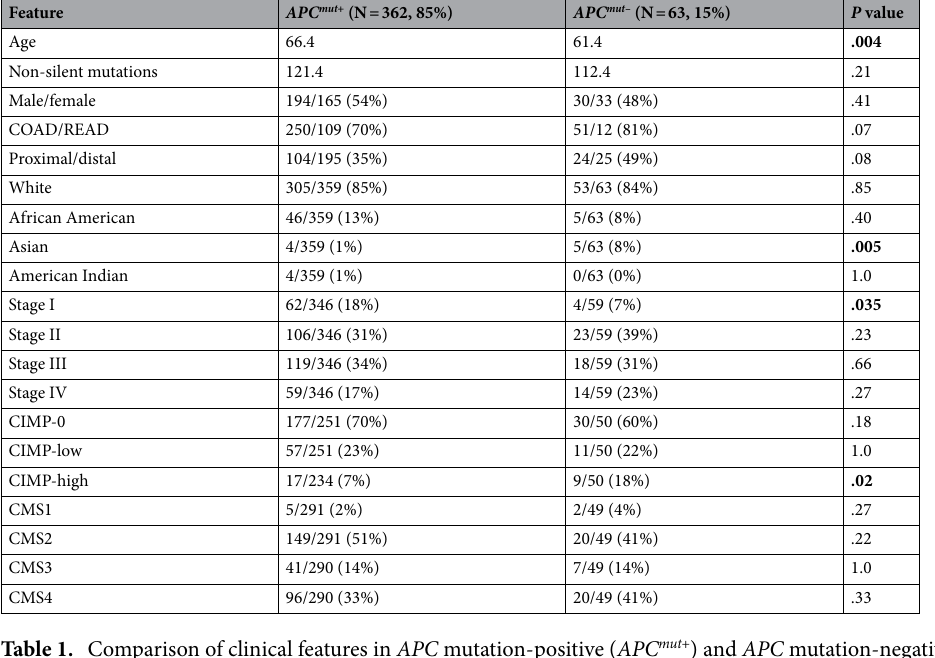
Table 1. Comparison of clinical features in APC mutation-positive ( APC mut + ) and APC mutation-negative ( APC mut– ) colorectal cancers. P values were calculated for comparisons between APC mut + CRCs and APC mut– CRCs from the TCGA dataset. A two-sample t-test with a two-tailed p value was performed for continuous features and a Fisher’s exact test with a two-tailed p value was performed for categorical data. A p value threshold of 0.05 was considered significant. CIMP, CpG island methylator phenotype was defined by unsupervised clustering as reported byGuinney et al . CMS, consensus molecular subtypes of colorectal cancer determined by Guinney et al. Significant values are in bold.